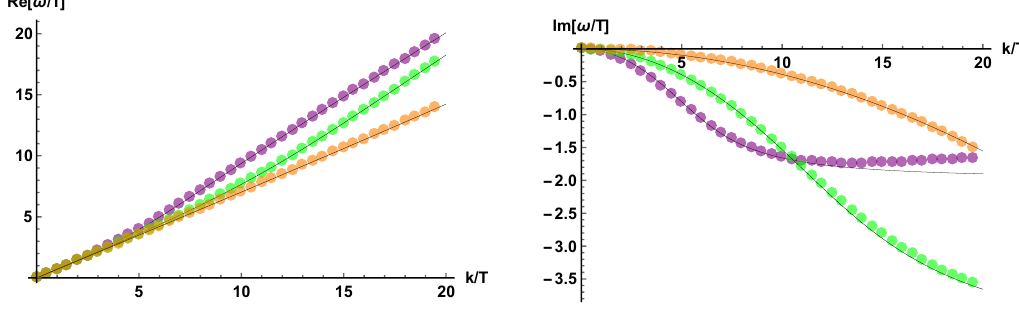
Figure 15 . The numerical data for the lowest sound mode for m=T = 0 ; 10 ; 50. The black line is the (cid:12)t to the Hydro+ formula